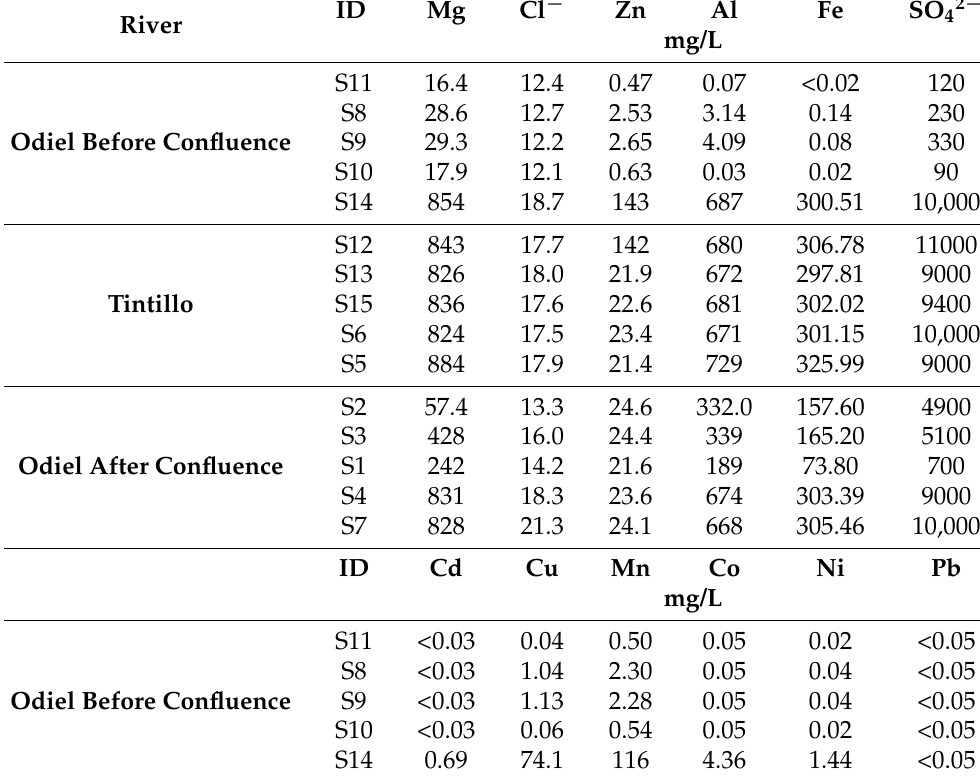
Table A2. Elemental composition of water samples from the three analyzed river sections. Photome- try for SO 42 − and Cl – and MP-AES for the rest of the